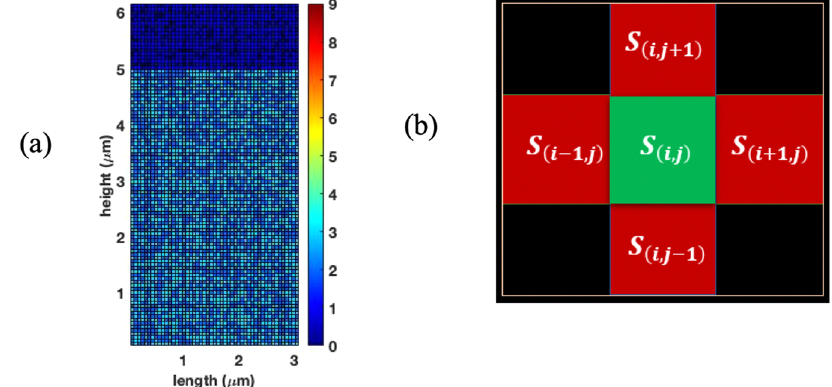
Fig. 1 CA simulation domain. a The simulation volume at a time t = 0 and b the Von Neumann